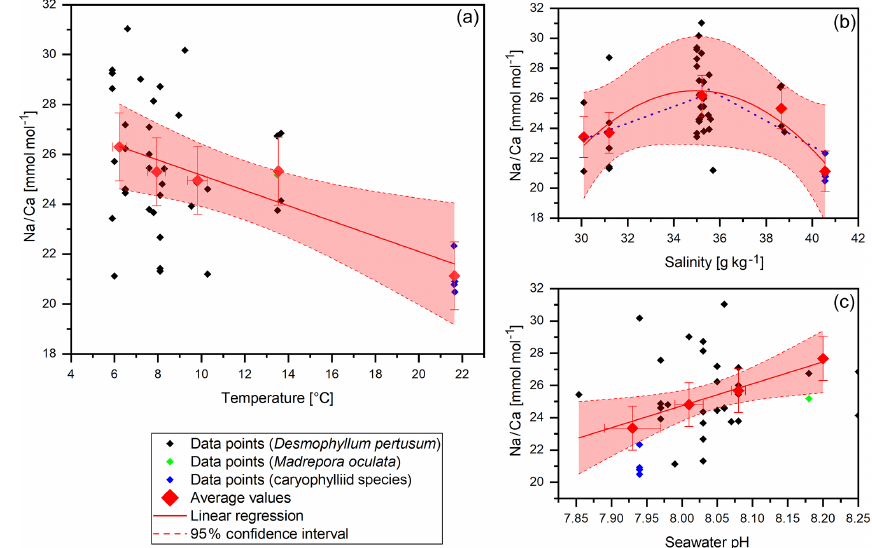
Figure 3. Na / Ca data (without COC) plotted against water temperature, salinity and pH. Red diamonds indicate averaged values for temper- ature ranges. Temperature ranges are 5–7, 7–9, 9–11, 13–15 and 21–23 ◦ C. The x error relates to the SD of the temperature or salinity mean. The y error bars indicate 2SD of the JCp-1 mean. Red lines are linear regressions of the averaged values with the 95% confidence interval shaded. Blue dotted lines indicate linear regressions for different salinity